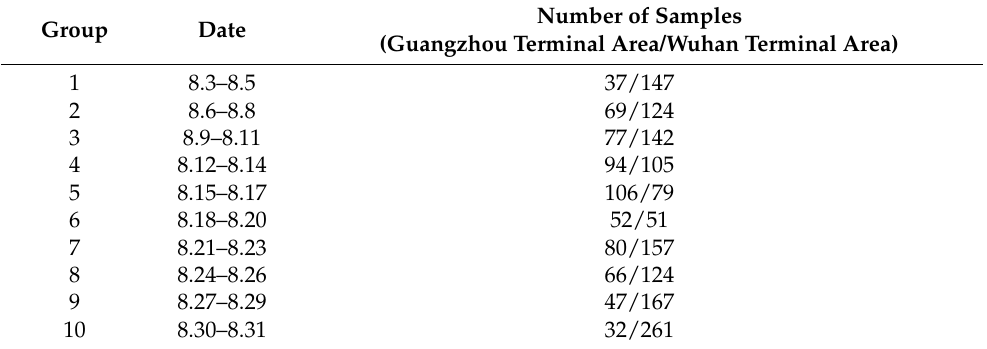
Table 1. Sample set partition.